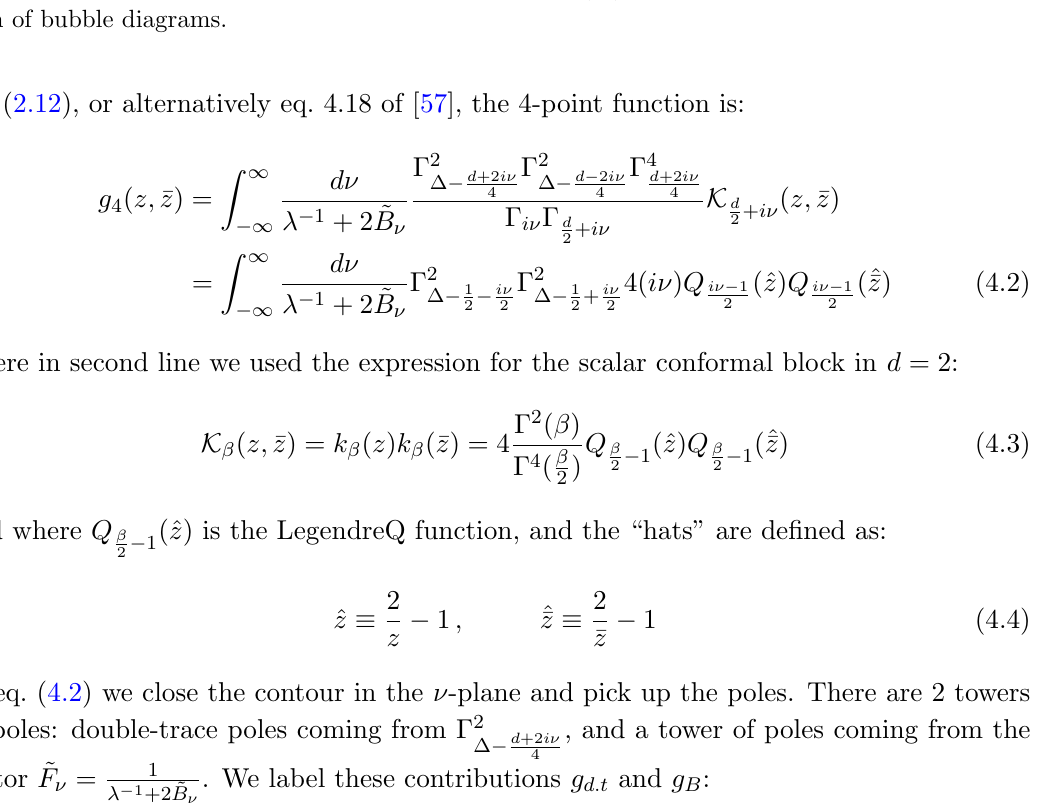
Figure 12 . The exact 4-point function in the large- N O ( N ) model on AdS is given by an in(cid:12)nite sum of bubble